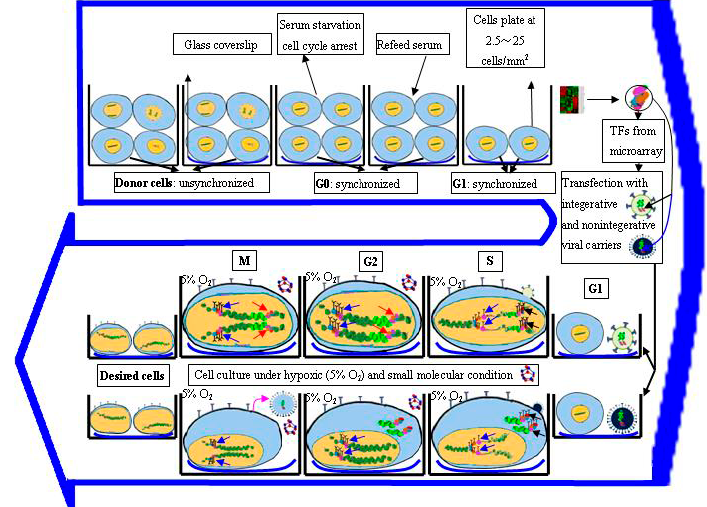
Figure 1. Reprogramming is the process of switching a cell fate from a donor cell to a desired cell, needing orchestrated interactions between the intrinsic factors of endogenous genes and the extrinsic factors from culture microenvironment such as optimal cell plating density, glass coverslip, appropriate small molecules, and hypoxic conditions, e.g., 5% O 2 . The donor cells are induced to cell cycle arrest at Gap 0 (G0) phase by transient serum starvation, and synchronized state to reenter cell cycle after re-feeding with serum. At Gap 1 (G1) phase, the donor cells are transduced with integrative or nonintegrative viral carriers, and returned to a transient Synthesis (S) phase. During S phase the exogenous transcription factors (TFs) from microarray data are transcribed and synthesized (black arrows), initiating endogenous pluripotency/multipotency gene expression (blue arrows). The integrative viral expression is within nucleus, and nonintegrative viral expression is in the cytoplasm. During Gap 2 (G2) phase, nucleosomes mature and histone biogenesis is repressed; the endogenous genes are further expressed to appropriate levels (blue arrows), simultaneously, the extrinsic viral TFs begin to be inhibited (red arrows). During Mitosis (M) phase, many TFs and chromatin binding proteins are ejected from the chromatin; the integrative viruses are gradually silenced, and the nonintegerative viral TFs are gradually removed from host cells (purple arrow). Finally, the desired cells such as induced pluripotent stem cells (iPSCs) and induced neural progenitor cells (iNPCs) are induced [13,26,33,40].